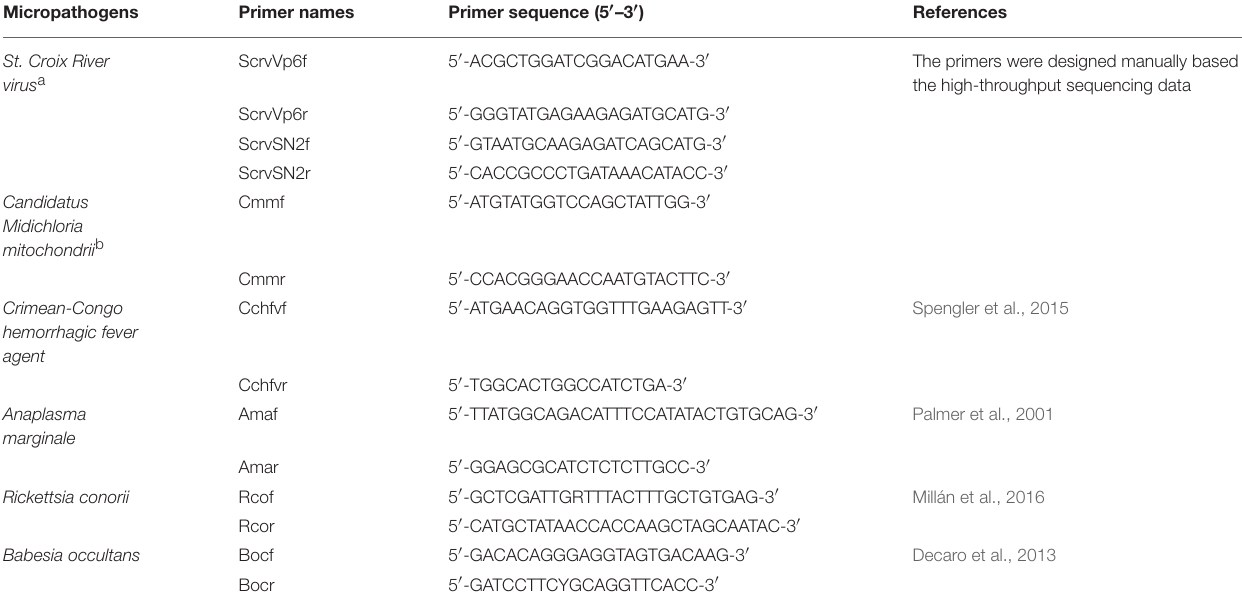
TABLE 4 | Target genes and list of primers used in this